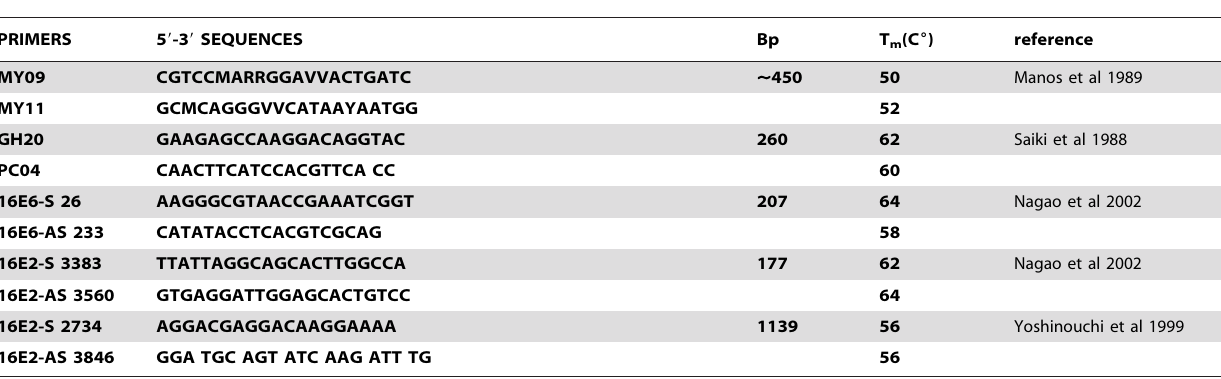
Table 1. Sequence, Tm and references of primers